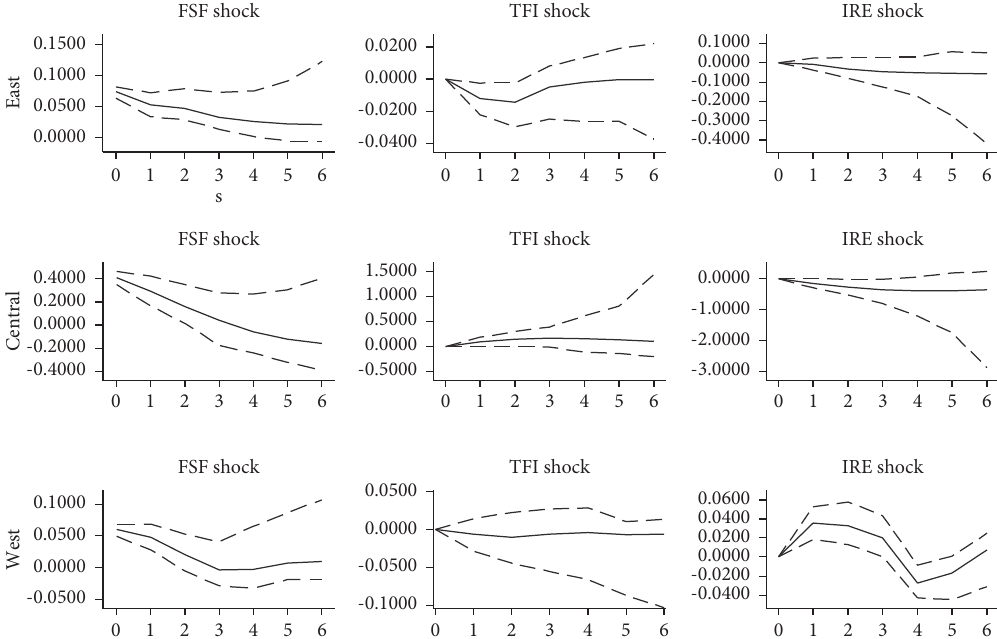
Figure 2: Pulse response of eastern, middle, and western regions’ technological finance and investment rate on financial